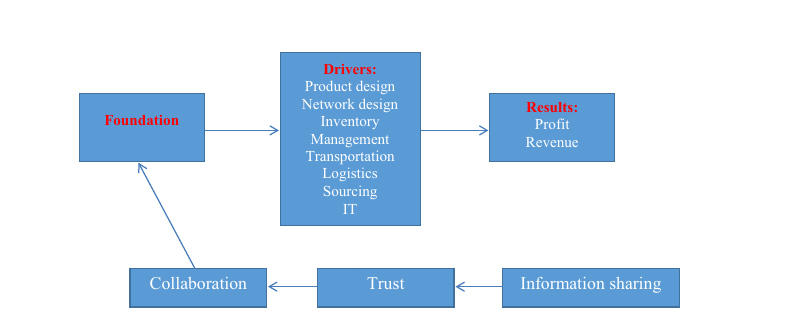
Figure 2. Supply